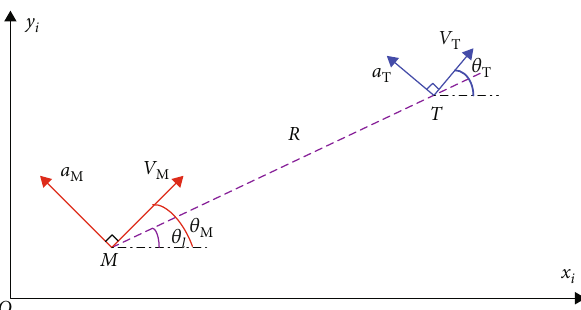
Figure 1: Missile-target relative motion